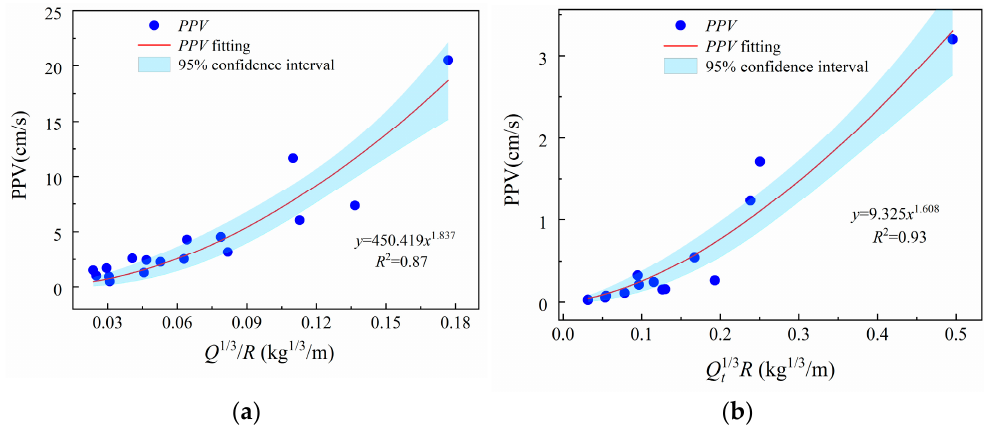
Figure 8. Vibration velocity attenuation law: ( a ) explosive blasting; ( b ) L-CDRB.